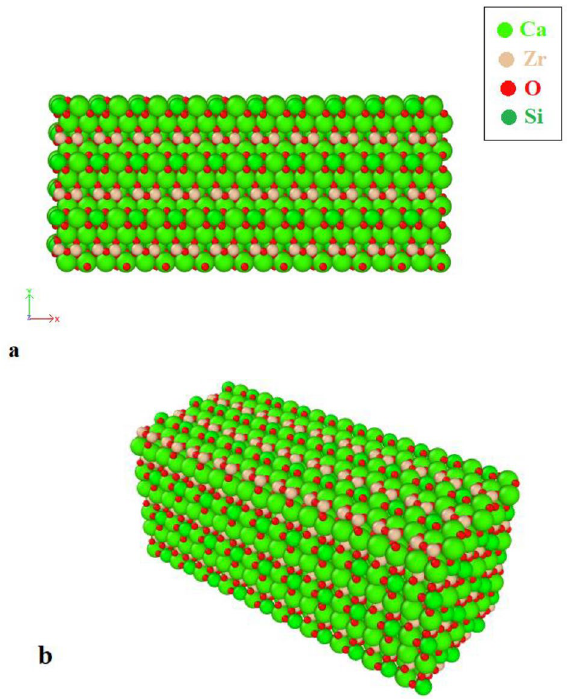
Figure 1. Schematic of modelled BAG-based nanostructure at ( a ) Front and ( b ) Perspective